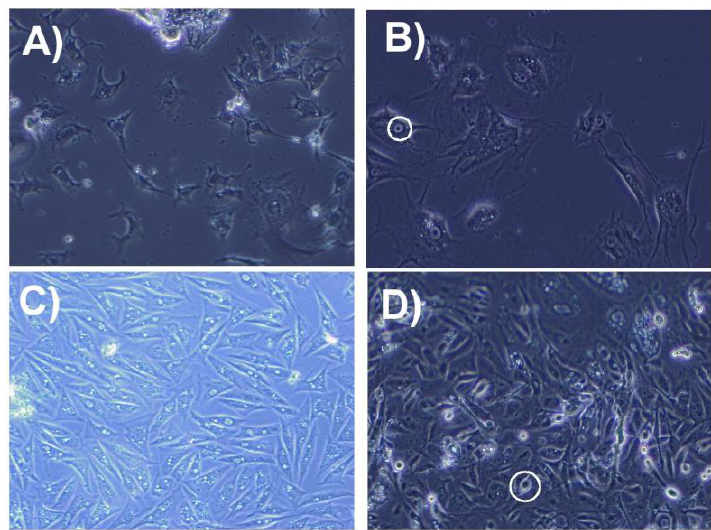
Figure 1. Morphological pattern of melanocytes isolated from Hanwoo muzzles of different breeds. The cells were selectively grown in basal media with 2.5% FBS after 14 d whereas fibroblast and keratinocytes disappeared after 7 d. (a) Primary cells seen here are with high dendricity, dendrites connecting each other,  100. (b) 1st passage cells maintained in basal medium with 5% serum concentration. The cells showed maturation, high dendriticity and slight accumulation of melanin in the circles,  200. (c) Mostly dividing cells; polygonal to elongated morphology and some cells also showed vacuolation,  100. (d) Melanocytes after 21 d of culture showed accumulation of melanin and the rounded structures in the circles are dead cells due to melanin toxicity, 